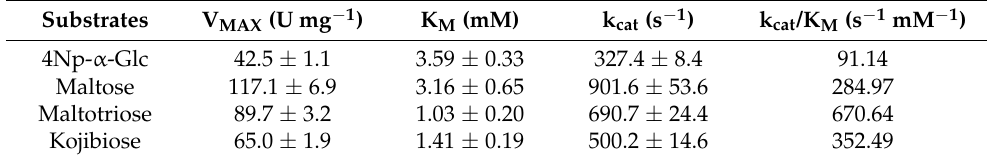
Table 1. Steady-state kinetic constants of Aglu1.